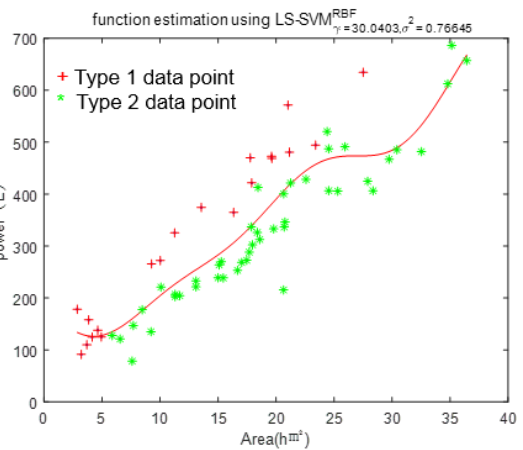
Figure 4. Rendering of LSSVM processing operation area and fuel consumption data.